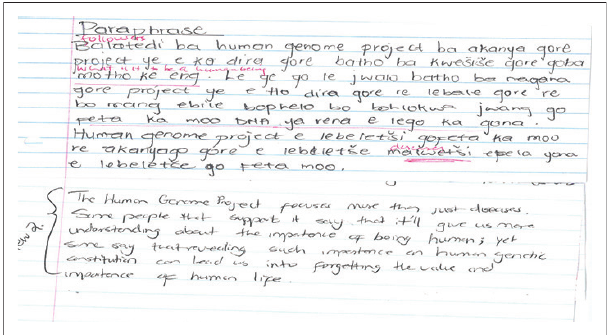
FIGURE 3: Excerpt